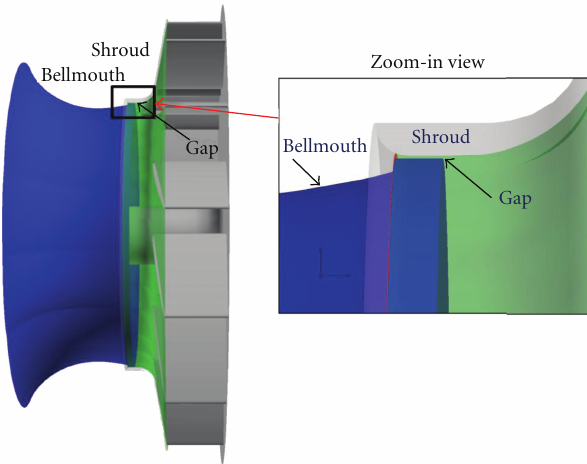
Figure 18: Gap and shroud configuration for B#1 impeller.